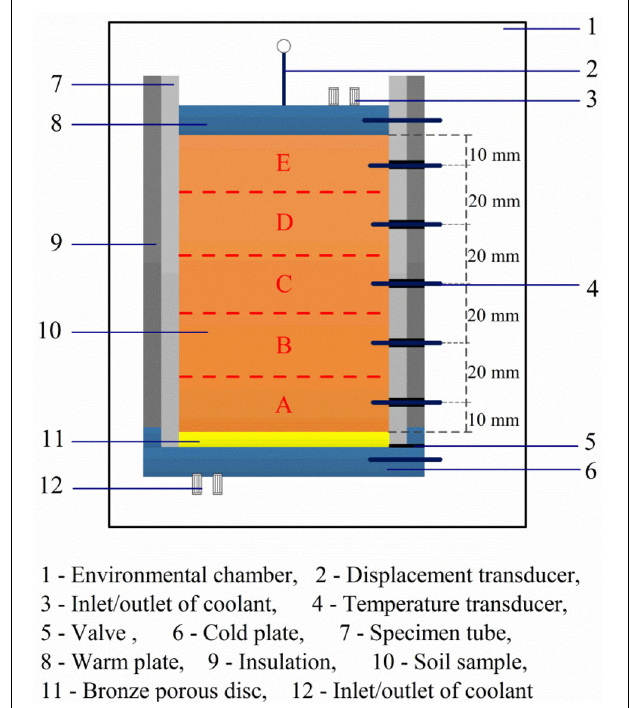
FIGURE 2 | Schematic of the freeze-thaw experimental apparatus.